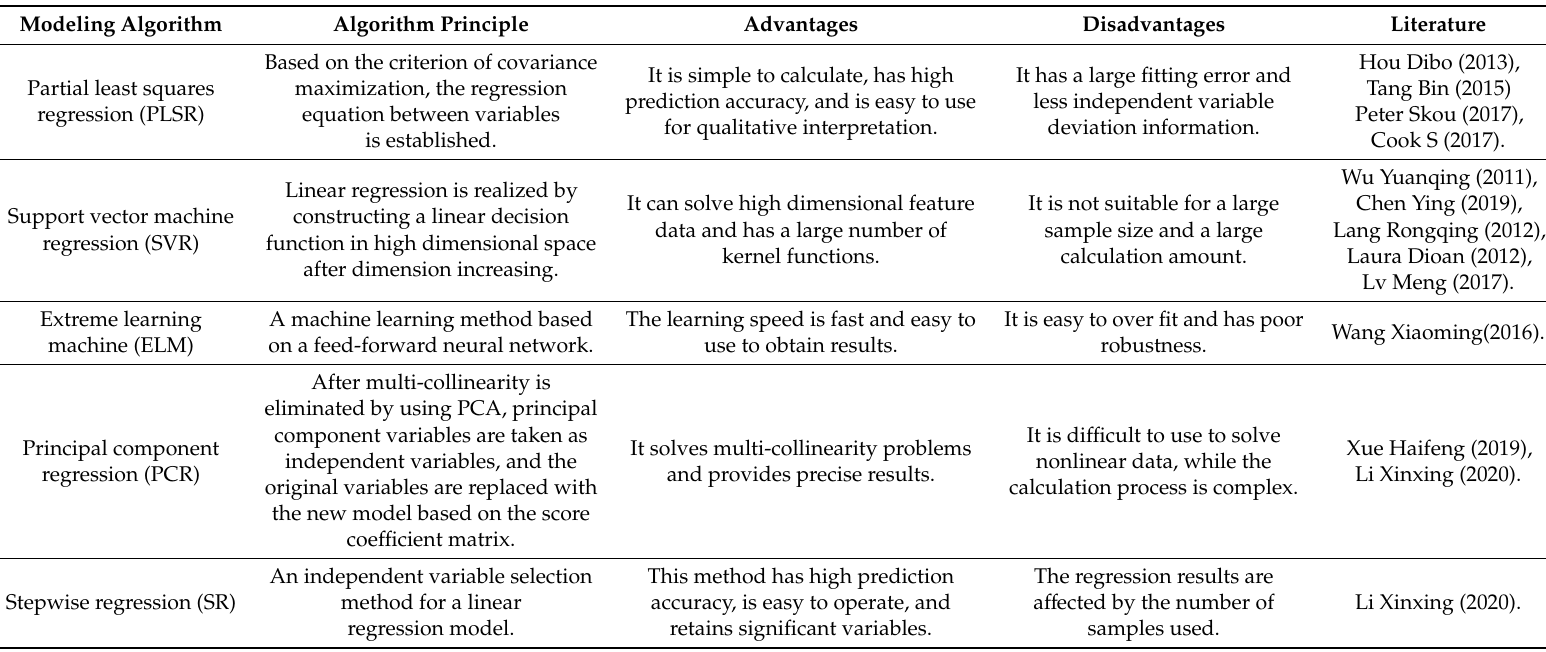
Table 4. Modeling algorithms of spectral